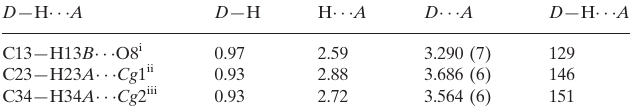
Hydrogen-bond geometry (A˚ , (cid:2)